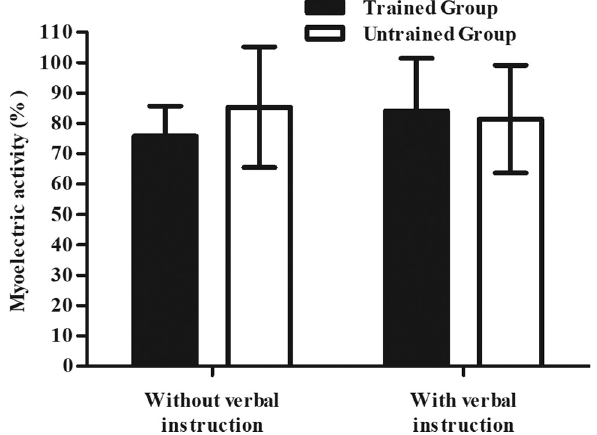
Figure 4 - Myoelectric activity of the biceps brachii muscle during the seated row at 70% 1RM with and without verbal instructions in trained and untrained group.